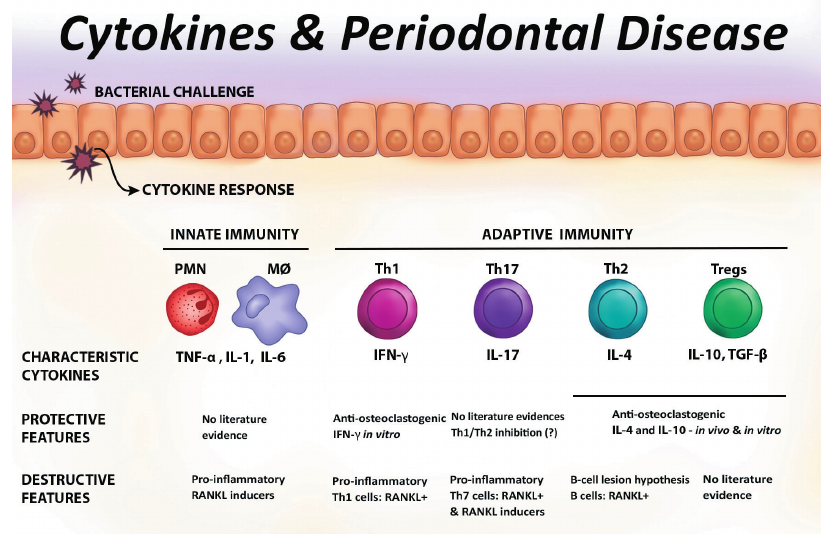
Figure 3- Cytokines and periodontal